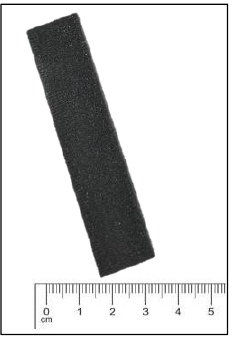
Figure 5. E ff ect of CF content in SLS-Printed fully cured thermose tt ing samples on Flexural Modulus.